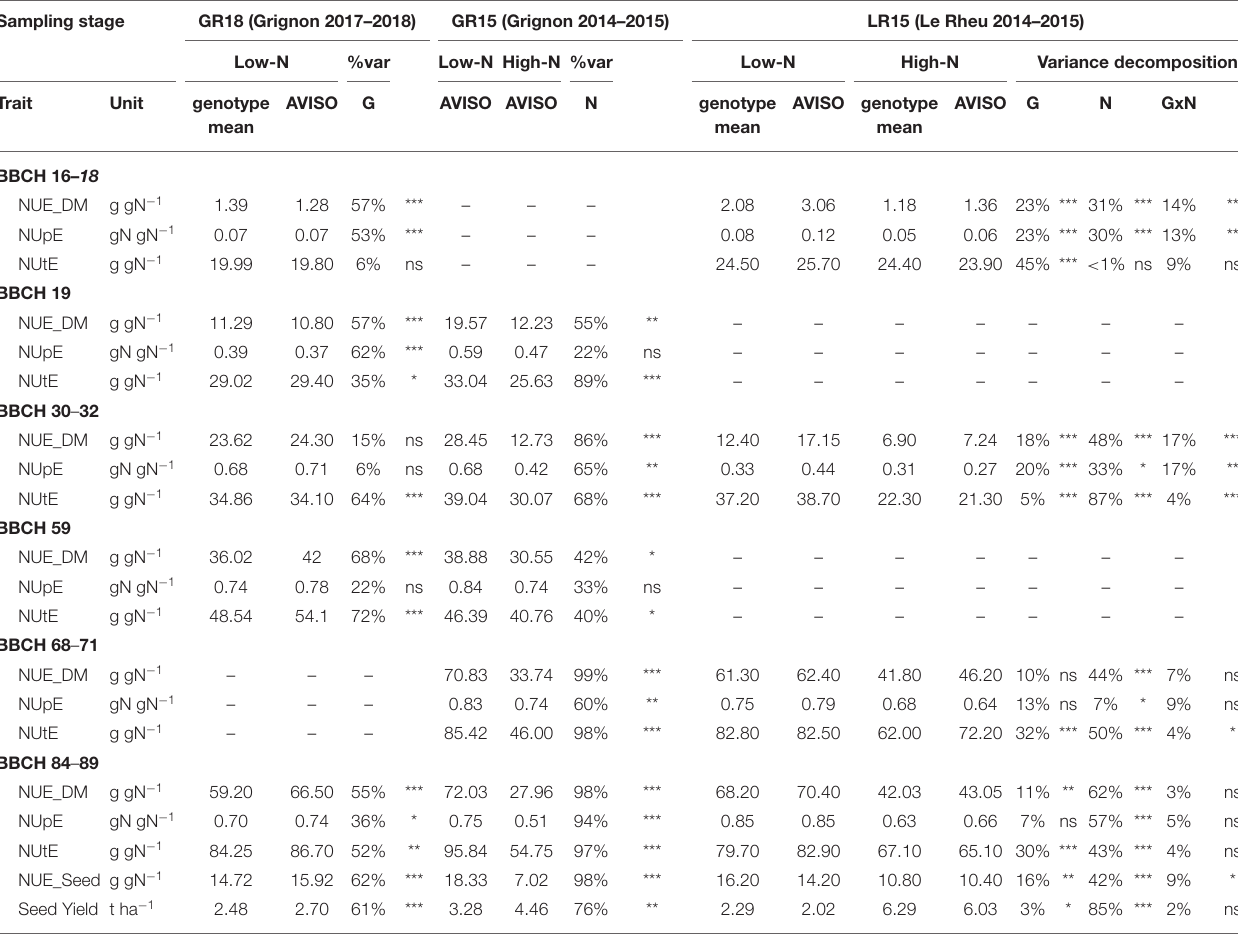
TABLE 3 | Effects of N condition and genotype on variation in the dry-matter-based N Use Efficiency (NUE_DM) and its components during the crop cycle in the three experiments. Sampling